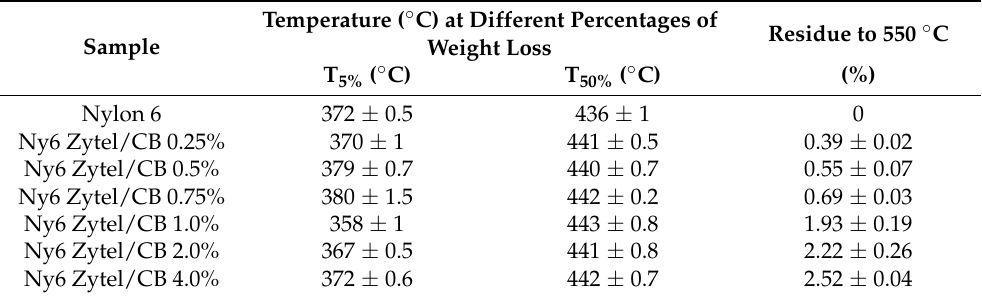
Figure 5. Melting endotherms obtained by DSC from Nylon 6 nonwoven fabrics and Ny6 Zytel/CB nonwoven fabrics at different concentrations (0.25, 0.5, 0.75, 1.0, 2.0, and 4.0 w%). The melting and crystallization enthalpies ( Δ H) as well as the degree of crystallinity for each of the nanocomposites obtained are shown in Table 3. The degree of crystallinity (Xc) was calculated using the following equation: 50